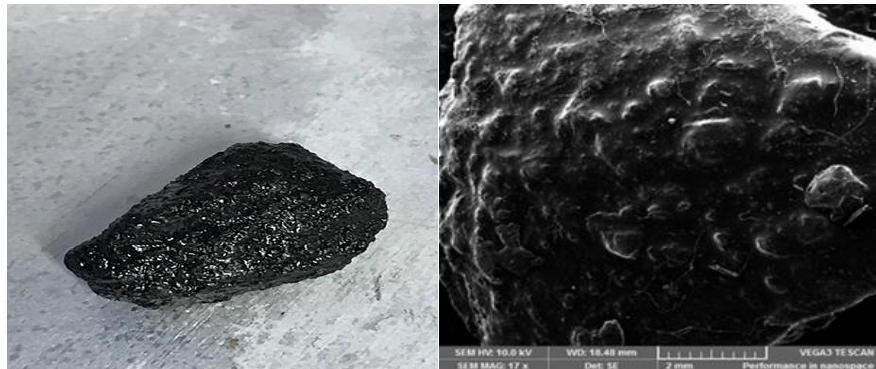
Figure 15. A piece of aggregate coated with base binder.